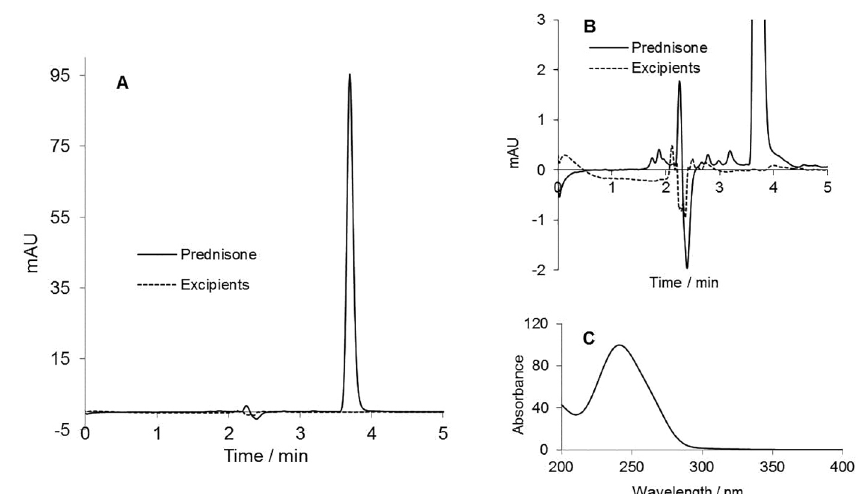
FIGURE 3 - (A) Chromatograms of prednisone reference standard at 14.0 µg mL -1 and placebo sample using the optimized conditions of the chromatographic method. (B) Expanded chromatograms of (A). (C) Spectrum of ultraviolet absorbance in the range 200-400 nm for prednisone.